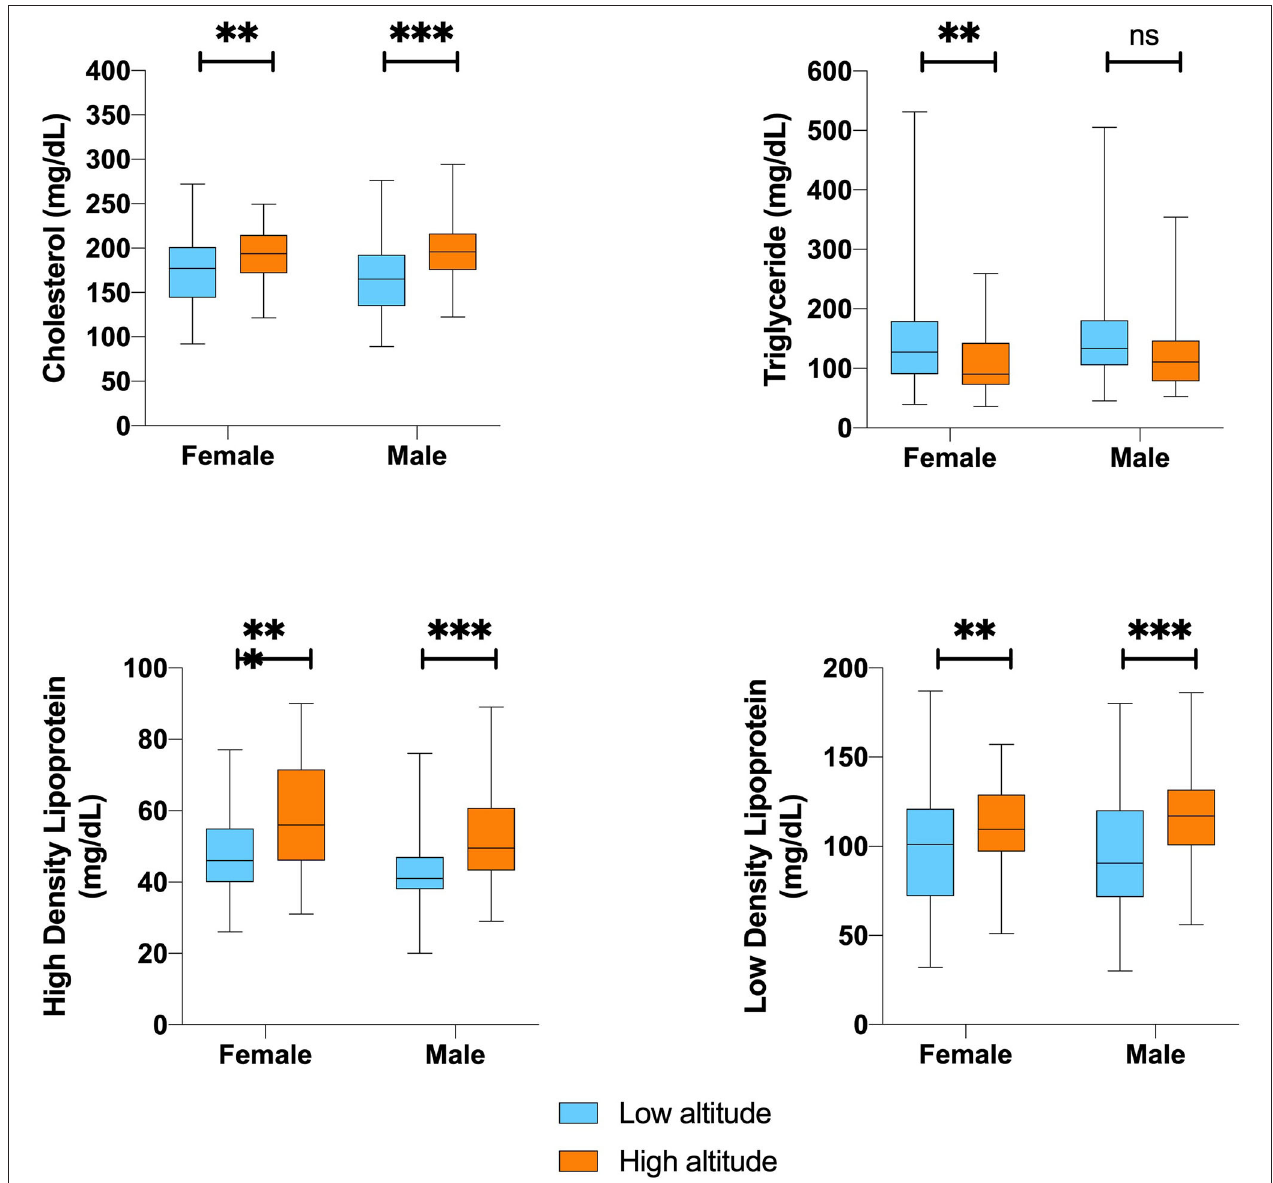
FIGURE 4 | Ancestry and main significant clinical and laboratory findings differences between low and high-altitude group. ** , ***Represents outliers